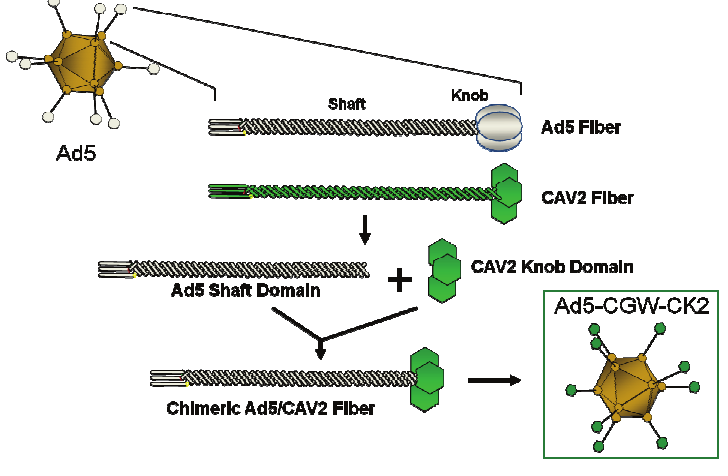
Figure 1. Schematic of fiber modification. Depiction of the Ad5 fiber replacement strategy. The fiber-modified Ad5-CGW-CK2 vector is structurally identical to Ad5, except for the knob domain of the cell-binding fiber protein. The Ad5 knob domain is genetically replaced by that of CAV2. Shaft and knob domains of Ad fiber proteins are